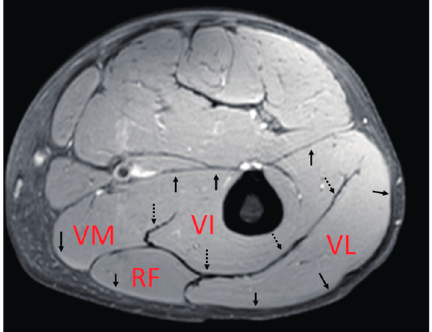
Figure 1. An example of the anatomical MR cross-sectional image of the center of the thigh. The quadriceps muscle includes the four heads of the muscle bellies of the vastus lateralis (VL), vastus medialis (VM), vastus intermedius (VI), and the rectus femoris (RF). The arrows show the aponeuroses surrounding the quadriceps muscle. The dotted arrows point to the thick aponeuroses referred to as “central aponeuroses” in this study.